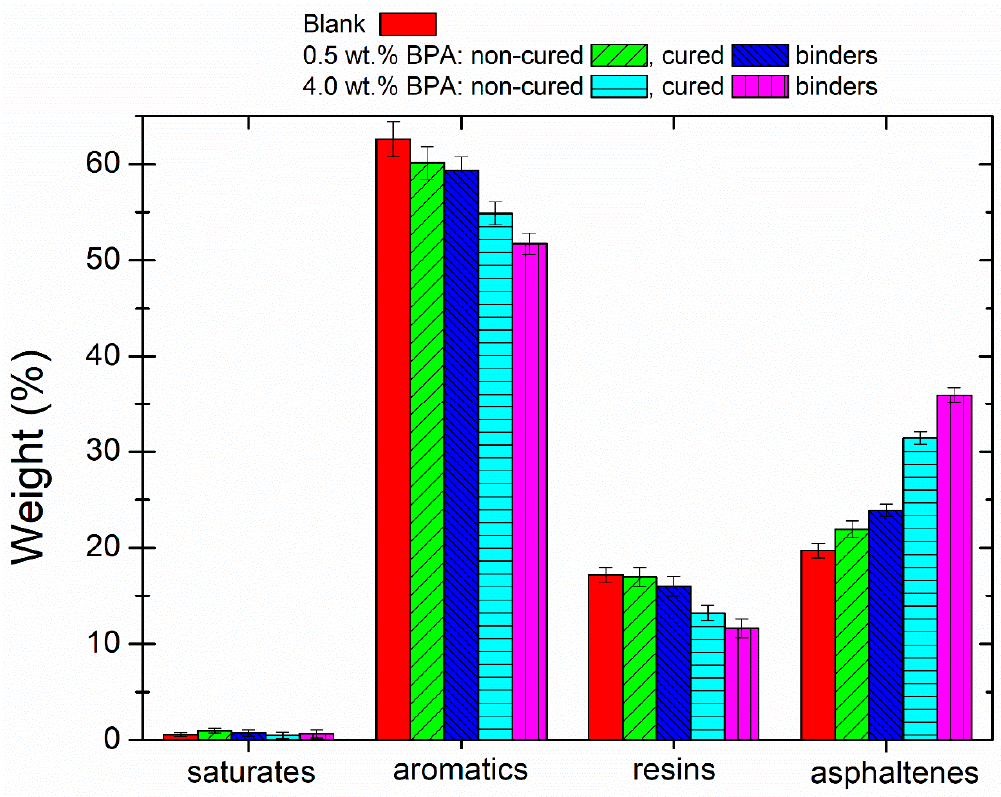
Figure 7. SARAs fraction obtained by TLC-FID of selected epoxy-modified binders and blank sample. Delving deeper into the microstructure, MDSC conducted on these selected binders also provides valuable information. As reported by Masson et al. [38,39], four events can usually be observed in the nonreversing heat flow curves when the di ff erent bitumen fractions reorder with increasing ◦ temperature: a first event characterized by a broad endothermic background located from − 30 to 85 C; ◦ two exothermic events typically centered at ca. − 5 and 25 C; and the fourth event, an endotherm from ◦ 25 to 80